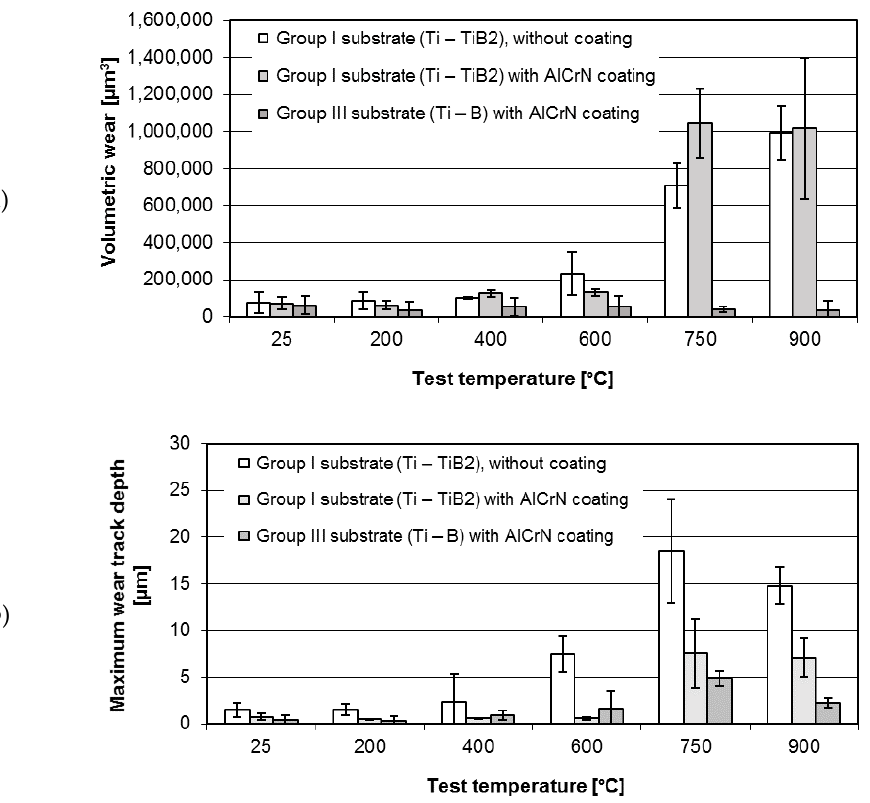
Figure 7. The average disc volumetric wear ( a ) and the maximum wear track depth ( b ).